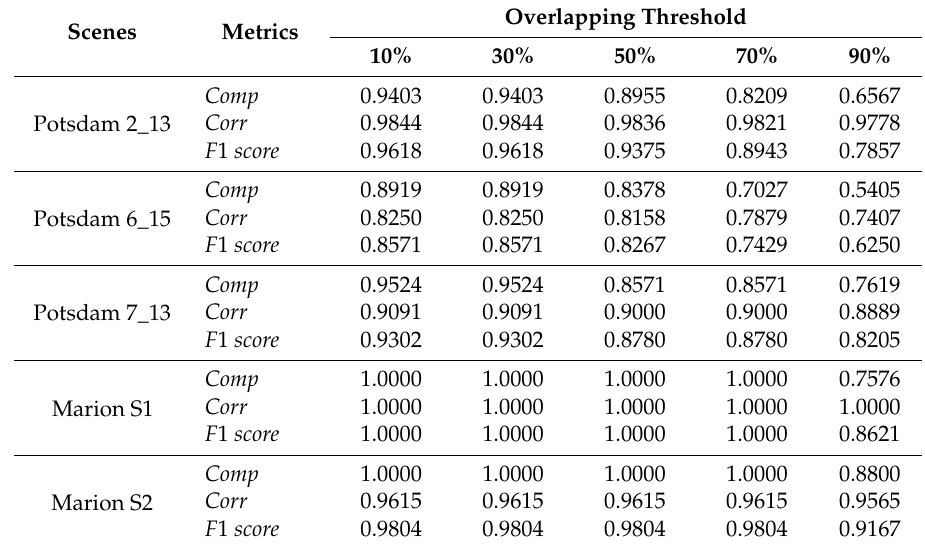
Table A2. Accuracies of CNN_ACM_2 at the scene level.